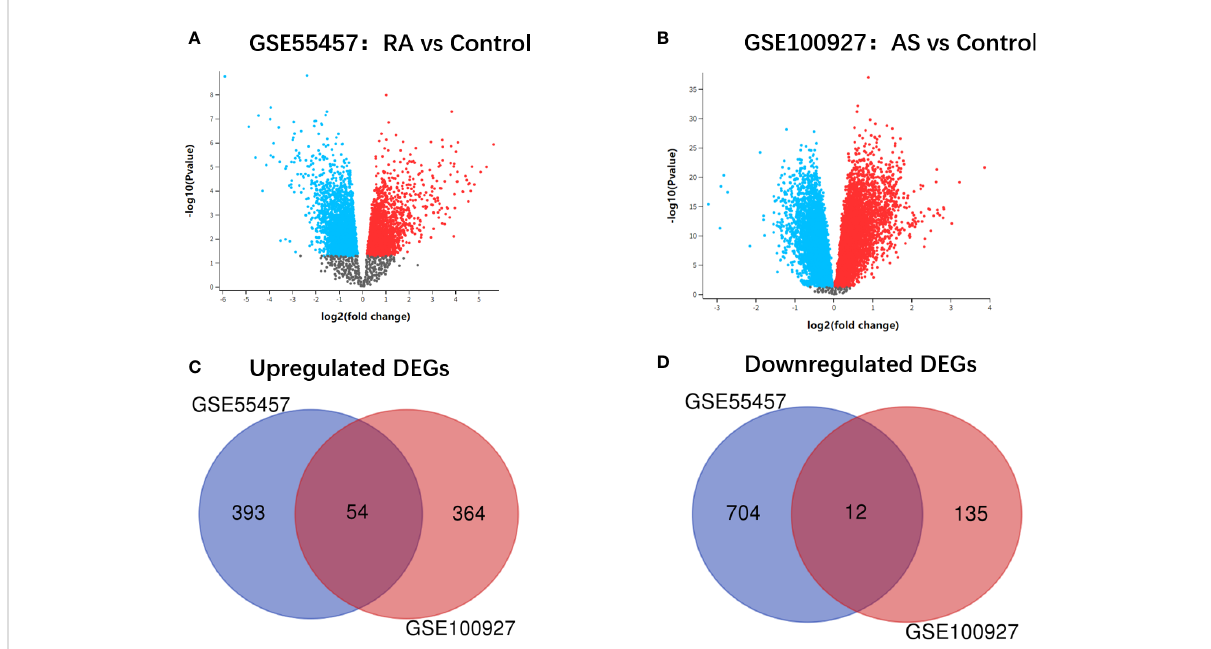
FIGURE 2 (A) Volcano plot of GSE55457. (B) Volcano plot of GSE100927. Upregulated genes are marked in red; downregulated genes are marked in bule. (C) Venn diagram of the 54 upregulated communal DEGs between RA and AS. (D) Venn diagram of the 12 downregulated communal DEGs between RA and